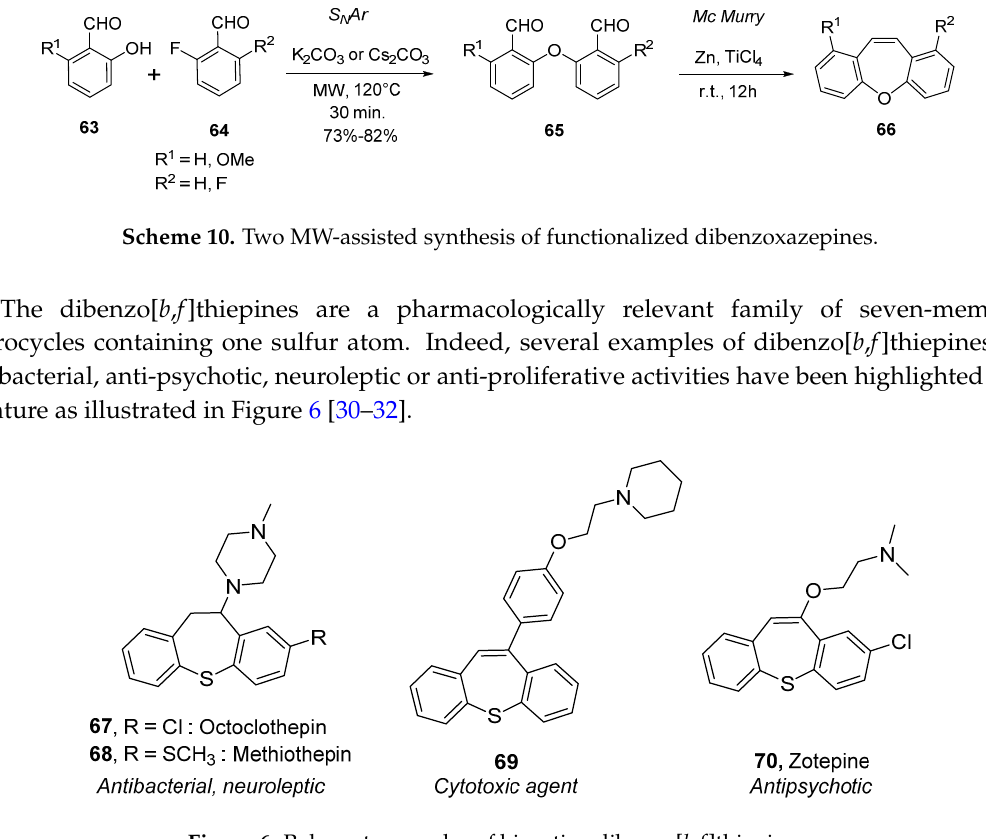
Figure 6. Relevant examples of bioactive dibenzo[ b , f ]thiepines.